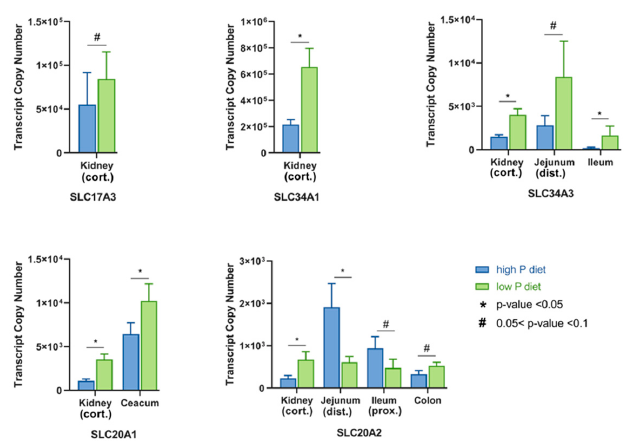
Figure 3. Transcript copy numbers of di ff erentially expressed P transporters in pigs receiving divergent P-containing diets (Trial 2). Sodium / phosphate co-transporters di ff erentially expressed between animals fed high and low P diets were identified. Superscripts indicate statistically significance (*, p < 0.05) and trend (#, p <